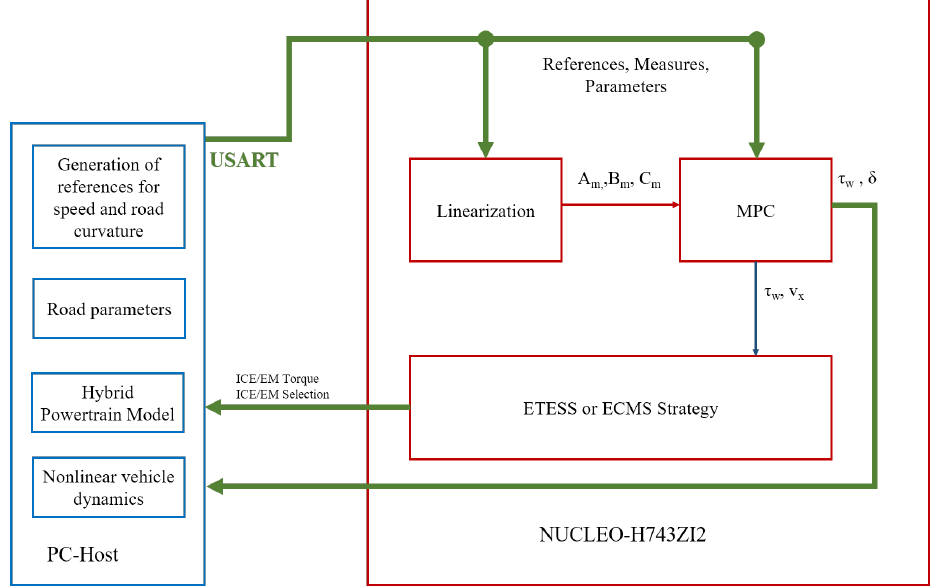
Figure 8. Block scheme for PIL